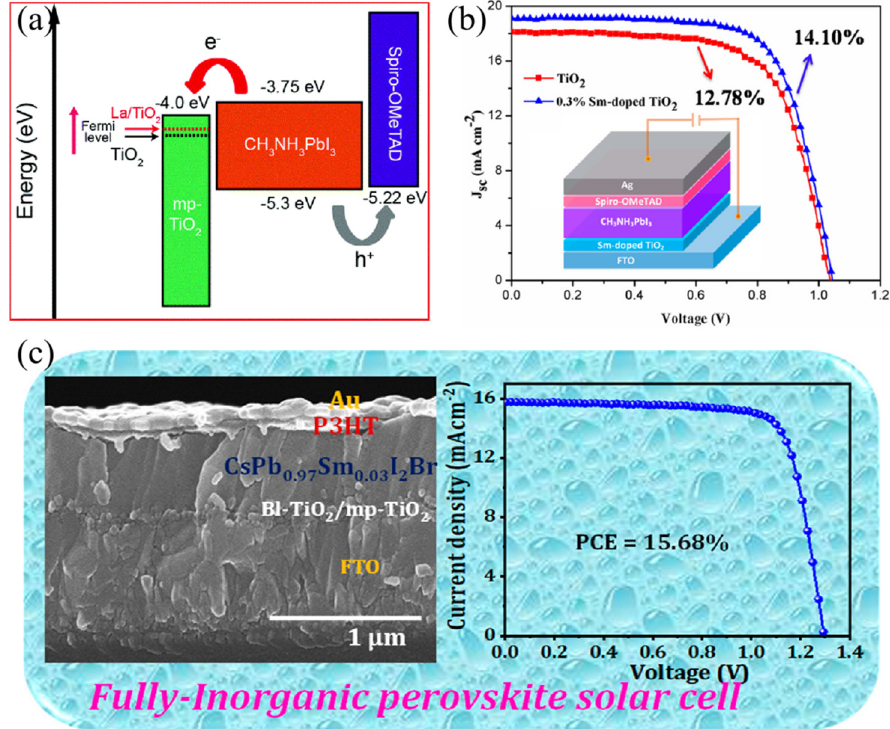
Figure 5. ( a ) Energy-level diagram for the device of FTO/La 3+ -doped TiO 2 /mp- TiO 2 /CH 3 NH 3 PbI 3 /Spiro-OMeTAD/Au (Reprinted/adapted with permission from Ref. [52]. Copy- Spiro-OMeTAD/Au (Reprinted/adapted with permission from Ref. right 2016 American Chemical Society); ( b ) J - V curves of PSCs with and without doping Sm 3+ ions (Reprinted/adapted with permission from Ref. [53]. Copyright 2017 American Chemical Society); ( c ) Cross - section of SEM image and J - V curve for the best perovskite device of FTO/cTiO 2 /mTiO 2 /CsPb 0.97 Sm 0.03 I 2 Br/P3HT/Au (Reprinted/adapted with permission from Ref. [57].